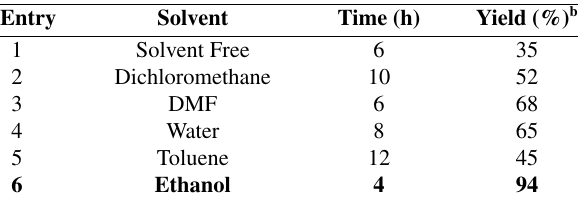
Table 2. The effect of solvents/reaction times on the yield of dihy- dropyridine